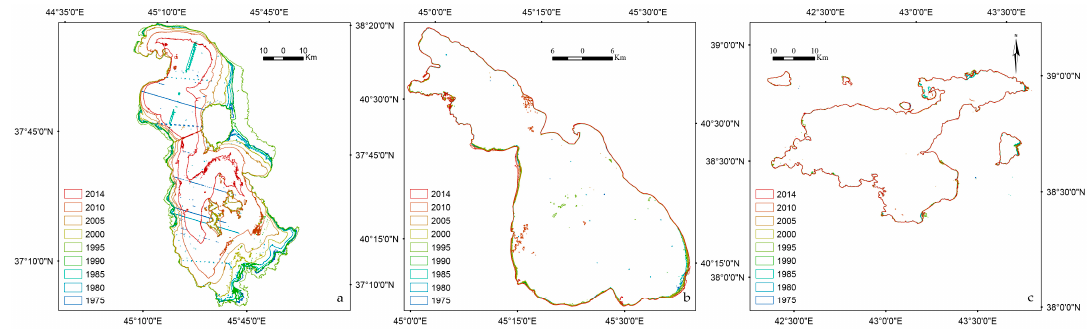
Figure 5. Temporal surface area changes (every five years) map in the period 1975–2015 for: ( a ) Urmia Lake; ( b ) Lake Sevan; and ( c ) Van Lake.